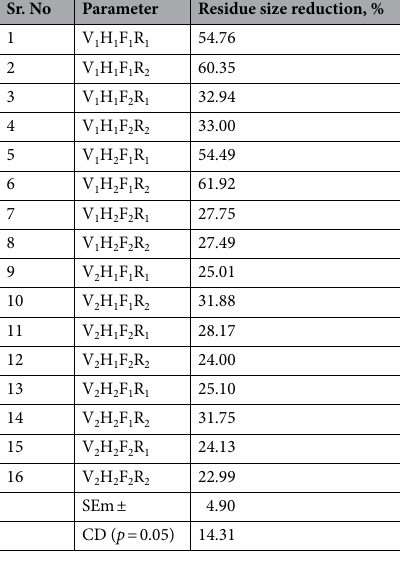
Table 12. The interaction effect of speed, vertical, and horizontal adjustment on residue size reduction. (F